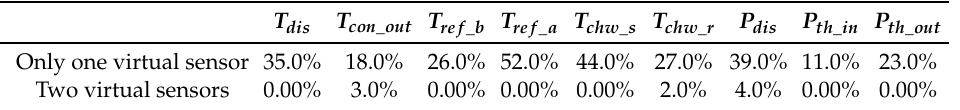
Table 5. False alarm rate of chiller